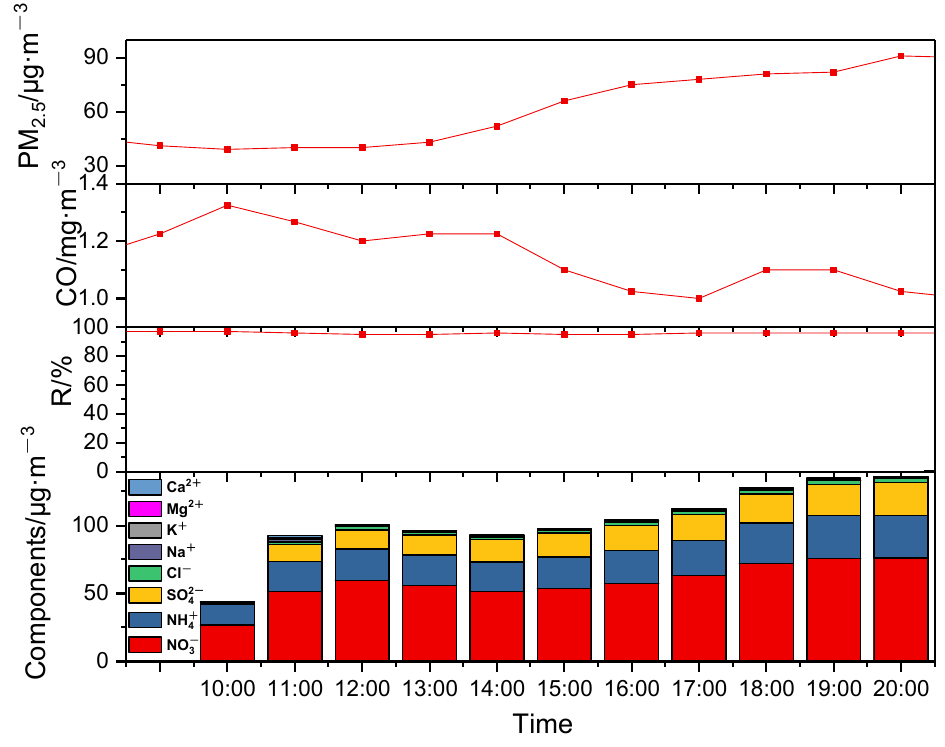
Figure 4. Hourly variations of the surface PM 2 . 5 and CO concentrations, RH at Xianning station and surface PM 2 . 5 chemical components at Wuhan ground-based supersite during 10:00–20:00 on 4 January, 2019.